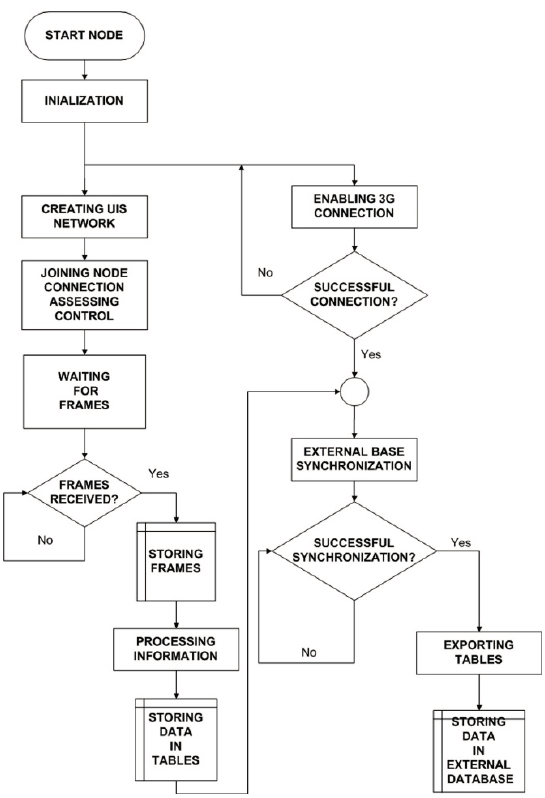
Figure 11. UIS Receiver node